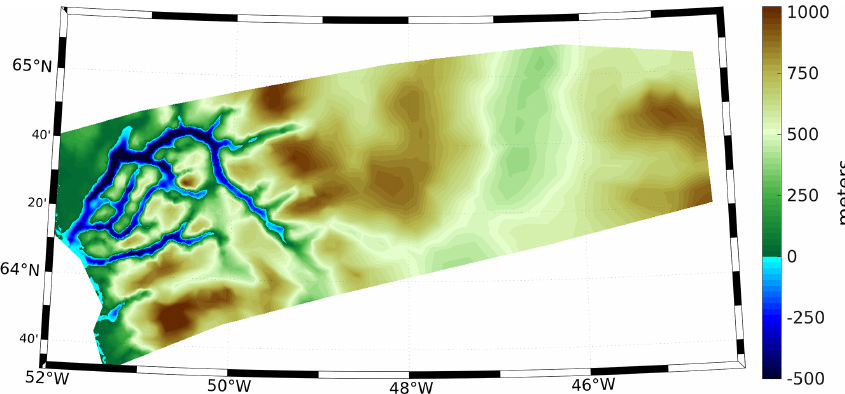
Figure 3. Bedrock topography for the model domain. Blue colors indicate areas that are below present-day sea level.